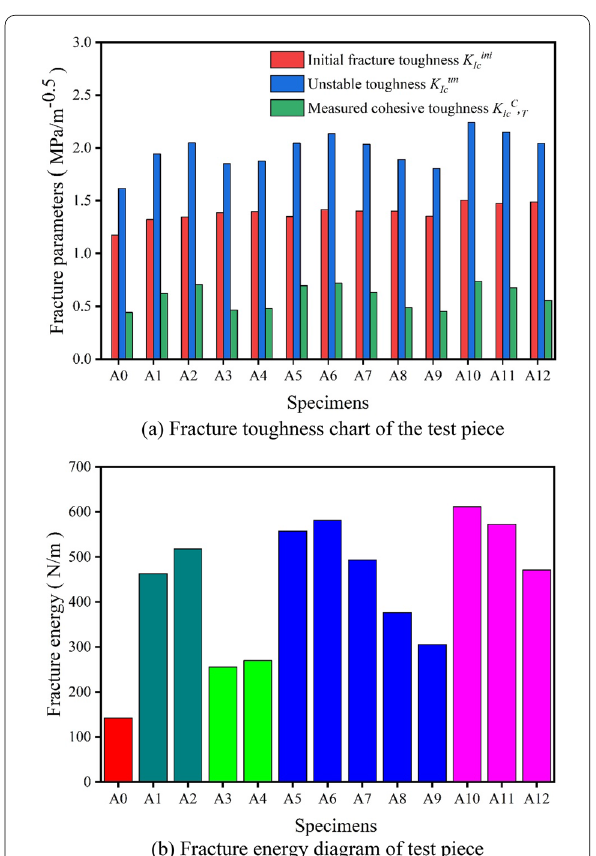
Fig. 11 Double-K fracture parameters and fracture energy diagrams of each group of